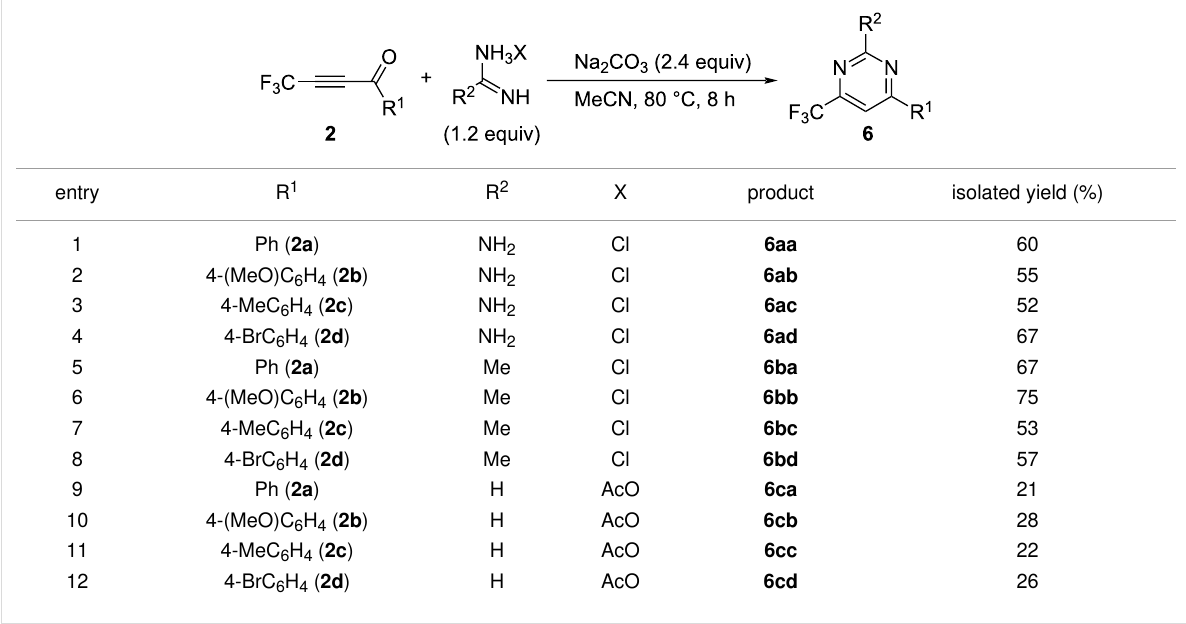
Table 6: Preparation of trifluoromethylated pyrimidine derivatives 6